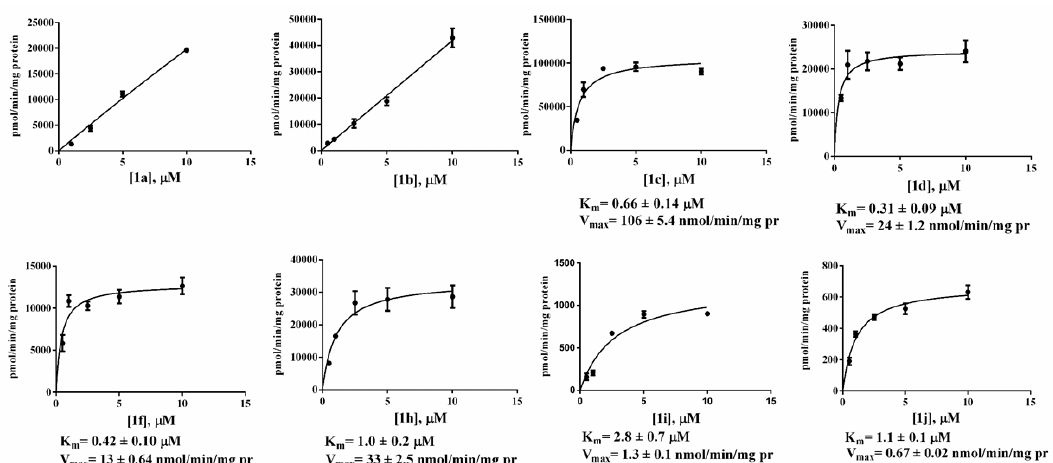
Figure 3. Action of h MAGL on di ff erent concentrations of 1a – d , 1f , 1h – j , in the presence of DMSO (10%, v / v ). The reactions were conducted in 50 mM Tris-HCl bu ff er (pH 7.4, 1 mM EDTA) with 25 ng / well of h MAGL. Values are the means of triplicates ± standard error. The kinetic parameters K m and V max were determined via computer-assisted nonlinear regression analysis using GraphPad Prism 6.0c (GraphPad Software, San Diego, CA 92108). Table 1. List of tested substrates with kinetic and modeling parameters.